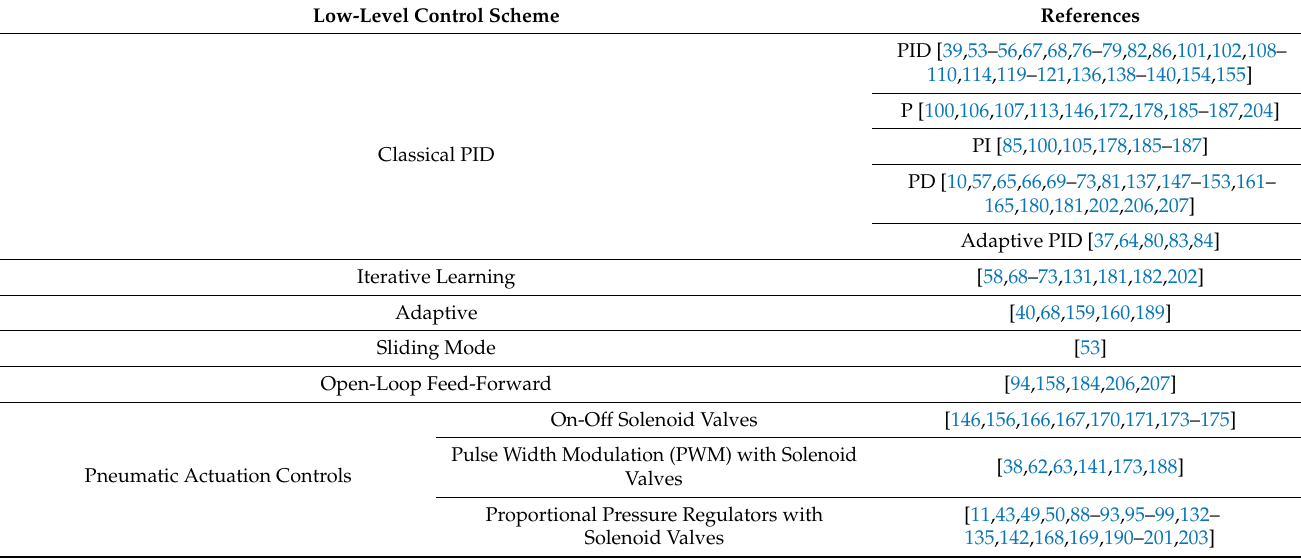
Table 6. Low-level control strategies used in